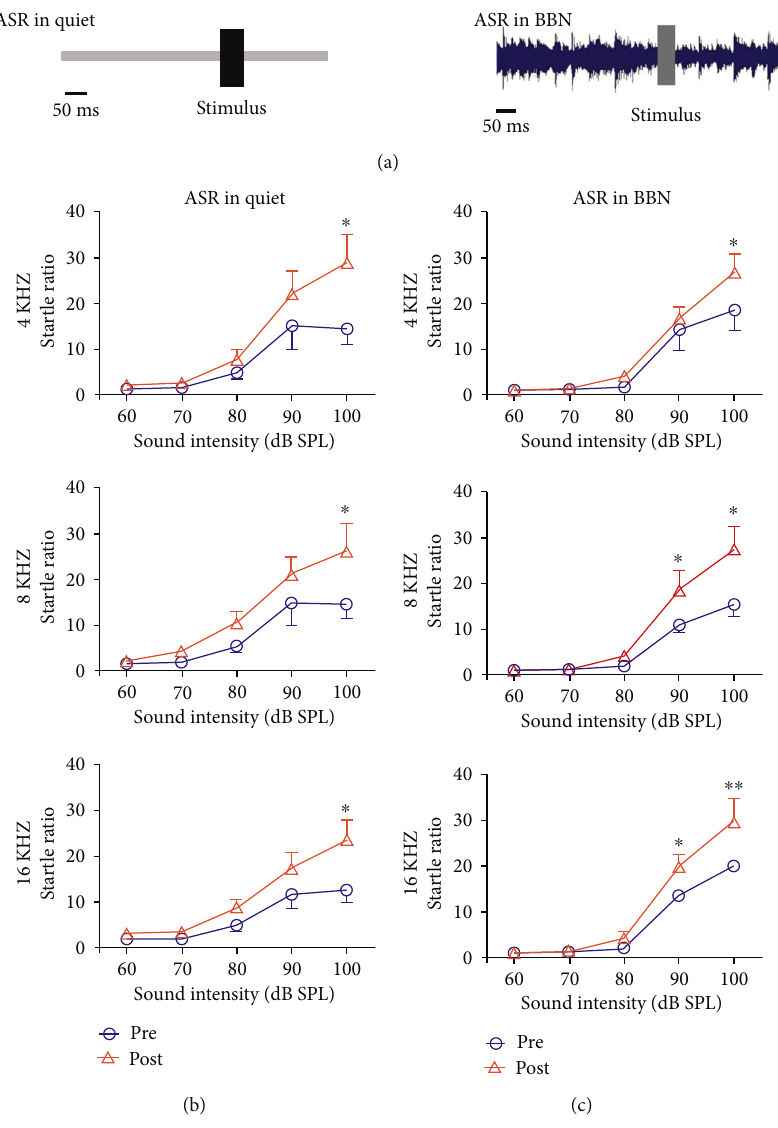
Figure 2: Behavioral assessment of animals by acoustic startle re fl ex. (a) Acoustic startle response was measured in a quiet background (left) and a broadband background noise (BBN) at 60 dB SPL (right). The startle sound was a narrow band noise burst centered at 4, 8, and 16kHz (50 ms duration, 60-100dB SPL in 10dB step). (b) The startle response was measured before and after 2 weeks of noise exposure. Clearly an increase of the startle response was detected in the noise group (Two-way ANOVA, p < 0 : 05 ). (c) Startle amplitudes tested under BBN before and after 2 weeks of noise exposure. Signi fi cant increases can be detected after noise exposure. (two-way ANOVA test and Bonferroni posttest, ∗ p < 0 : 05 , ∗∗ p < 0 : 01